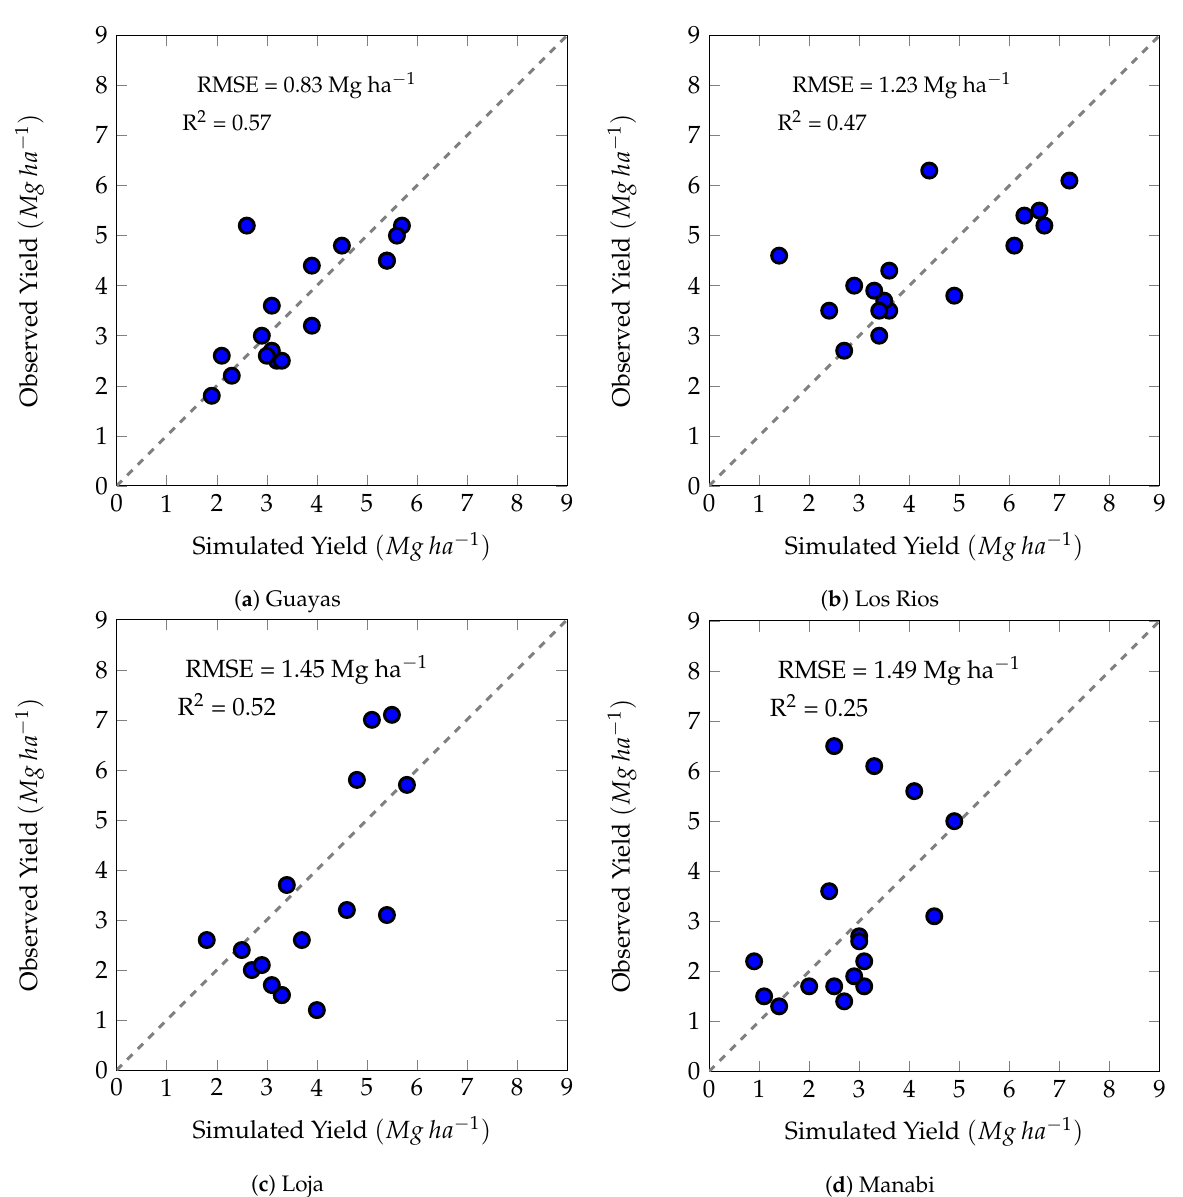
Figure 6. Observed vs. Simulated Yields (Mg ha − 1 ) from 2002 to 2018 in ( a ) Guayas, ( b ) Los Rios, ( c ) Loja and, ( d )